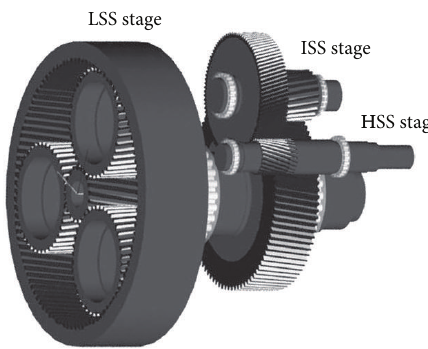
Figure 3: Wind turbine gearbox with one planetary and two parallel stages, adapted from [6].